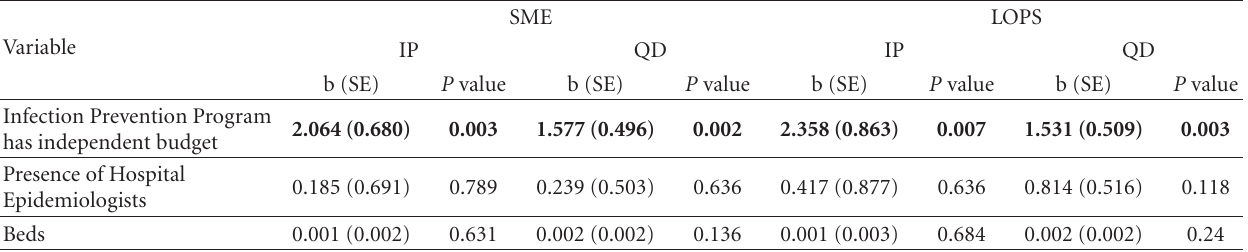
Table 4: Multivariable regression models of hospital characteristics and SME/LOPS